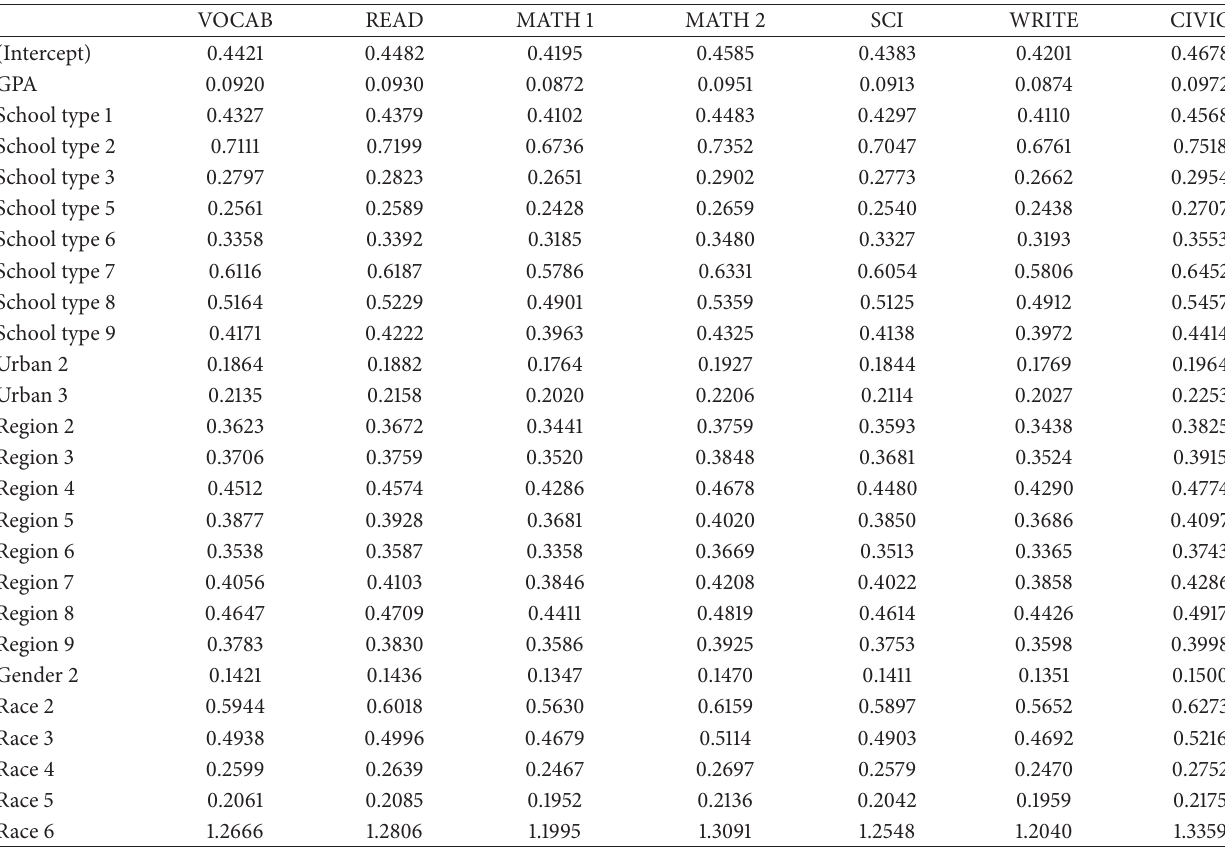
Table 3: Posterior standard deviations for 𝛽 .